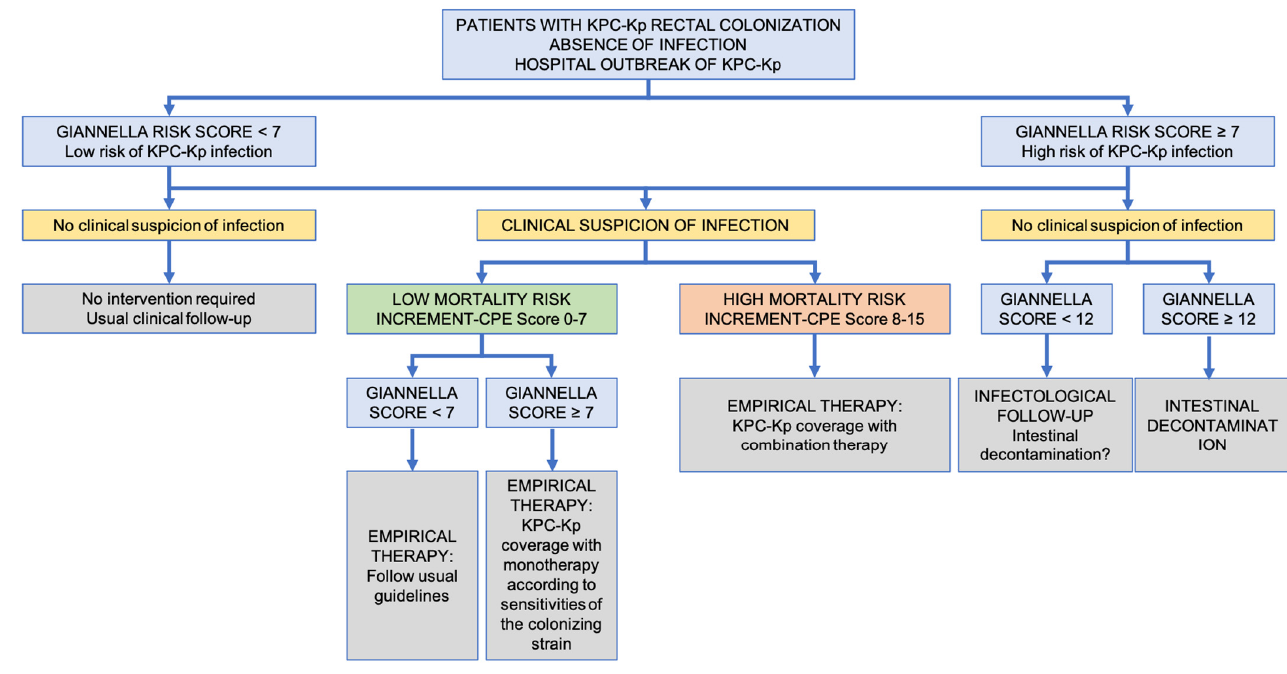
Figure 1. Clinical management algorithm arising from the ANGEL cohort. Reproduced with the kind permission of the authors of reference [45]. Table 5. Treatment recommendations for CR-Kp infections in critically ill patients.